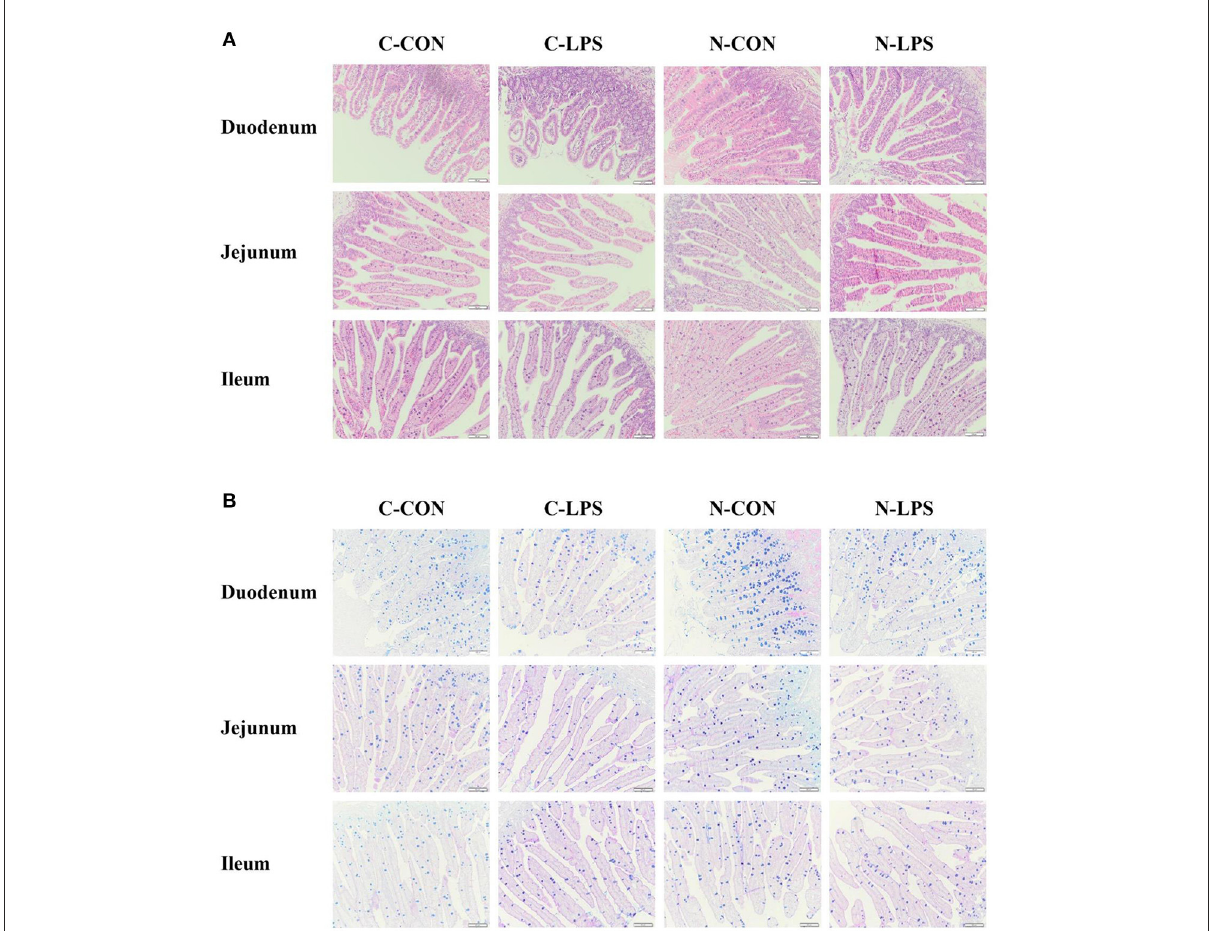
FIGURE1 Effects of maternal nucleotide supplementation on the intestinal morphology and globet cells density in lipopolysaccharide-challenged newborn piglets. (A) Hematoxylin and eosin (H&E) staining on the small intestine. (B) Alcian blue and periodic acid-schiff (AB-PAS) staining on the small intestine. Scale bar represents 100 µ m. C-CON, piglets were from the sows fed with basal diets and were challenged by sterile saline; C-LPS, piglets were from the sows fed with basal diets and were challenged by LPS; N-CON, piglets were from the sows fed with basal diets containing nucleotides and were challenged by sterile saline; N-LPS, piglets were from the sows fed with basal diets containing nucleotides and were challenged by